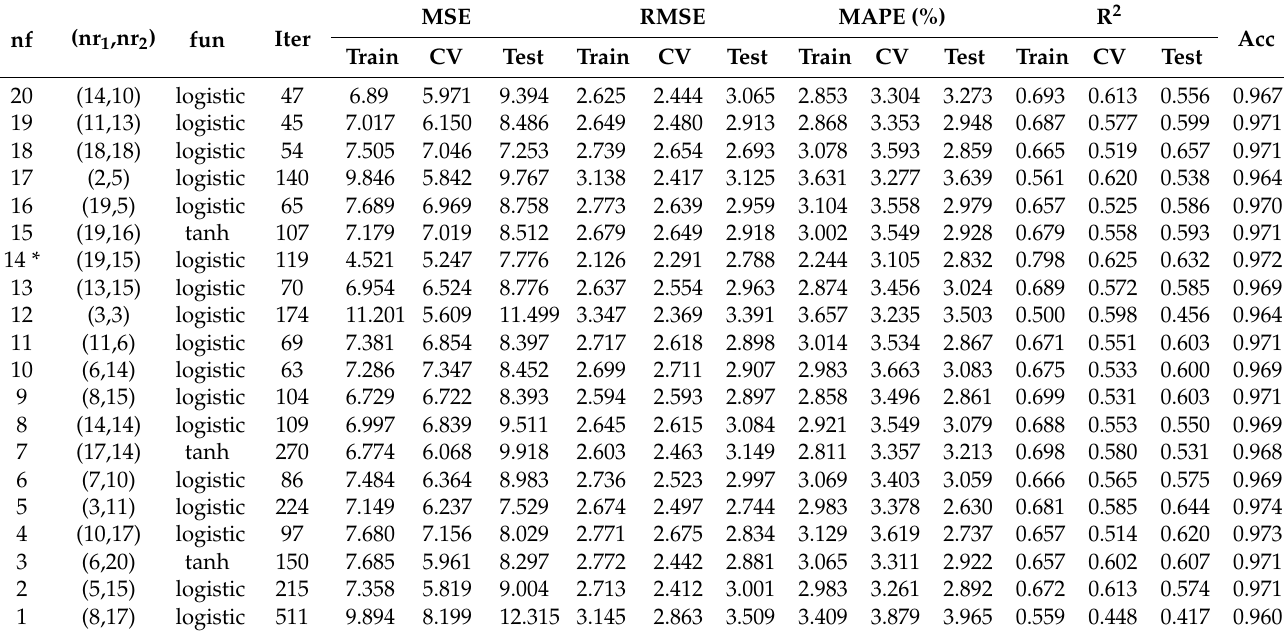
Figure 6. RGB ‐ based color features identified during neural network training loops. Figure 6. RGB-based color features identified during neural network training loops. Table 4. Various architectures of the BPNN model based on VI calculated from RGB images: with MSE, RMSE, MAPE (%), Acc, and R 2 in training, cross-validation, and test